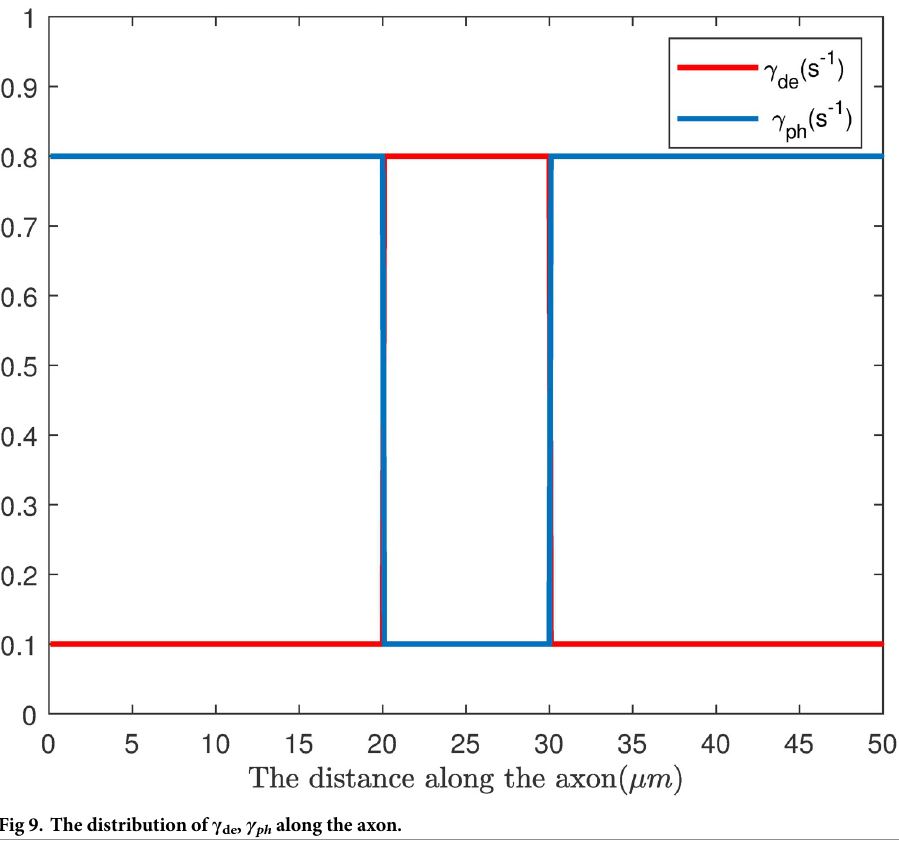
Fig 9. The distribution of γ de , γ